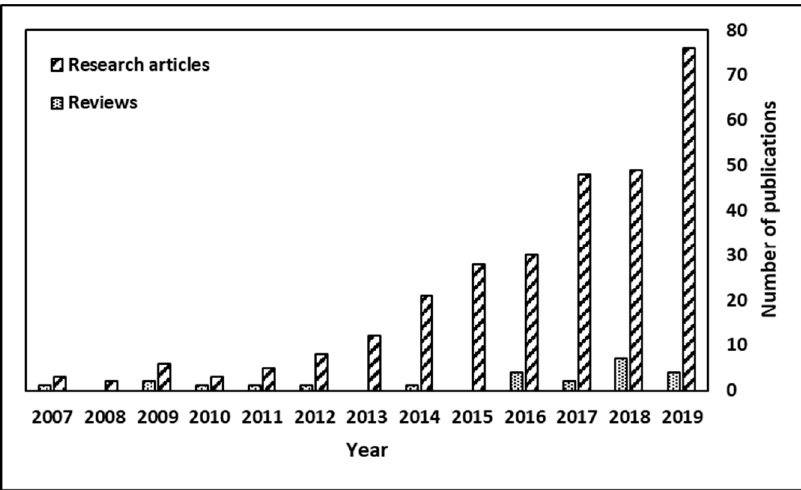
Figure 1. The increasing number of articles for oleogelation topic; searching the ISI Web of Science Core Collection Clarivate Analytics by the keywords «“food” and “organogels” or “oleogels”» Collection Clarivate Analytics by the keywords « “food” and “organogels” or “oleogels” » (updated to (updated to 13 November 2019). 13 November